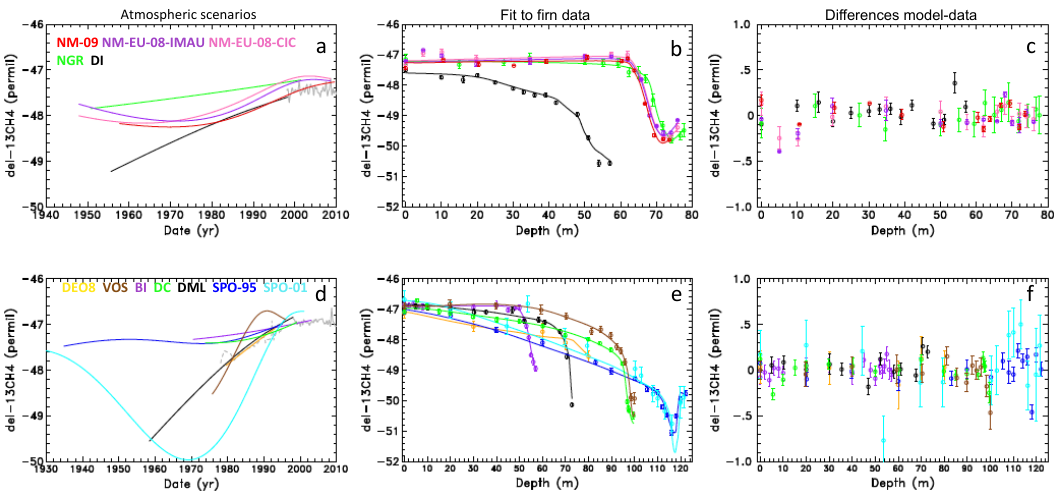
Figure 2: Single site δ 13 C(CH 4 ) trend scenarios (a, d), the fit to the firn data (b,e) and model-­‐data Fig. 2. Single site δ 13 C(CH 4 ) trend scenarios (a, d) , the fit to the firn data (b, e) and model-data differences (c, f) . NH sites ( a, b and c ). SH differences (c, f). NH sites (a, b and c). SH sites (d, e, f). The site names and color codes are as given in sites (d, e, f) . The site names and colour codes are as given in the legend of Fig. 1. The grey curve ( a and d ) represents air-archive data from the legend of Fig. 1. The grey curve (a and d) represents air-­‐archive data from Cape Grim (Francey et Cape Grim (Francey et al., 1998) and continuous atmospheric monitoring data from the NOAA-ESRL network. al., 1998) and continuous atmospheric monitoring data from the NOAA-­‐ESRL network.